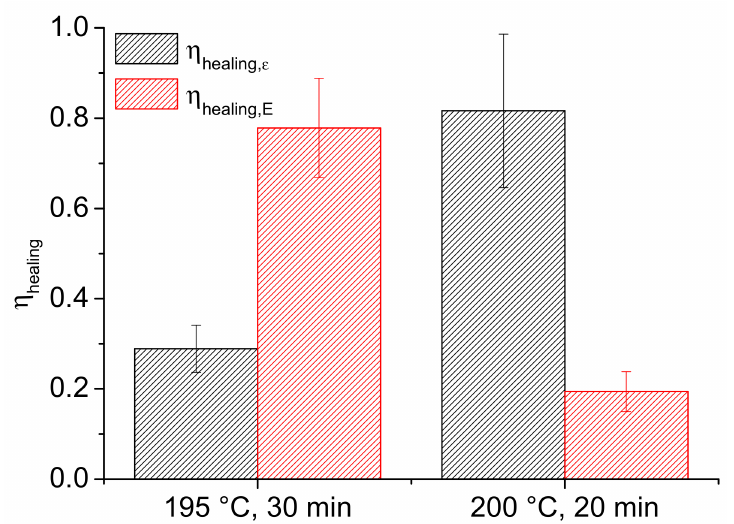
Figure 6. Healing e ffi ciency at di ff erent healing times and temperatures for toughened PBT.